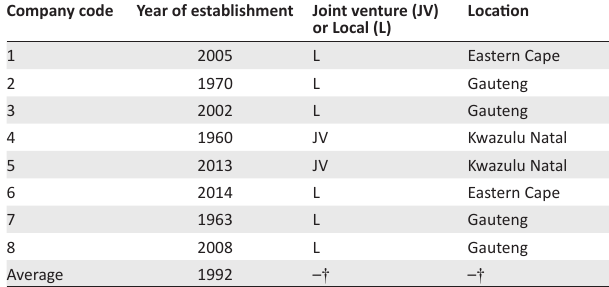
TABLE 1: Year of establishment, foreign affiliation, location, and major products. Company code Year of establishment Joint venture (JV) or Local (L)